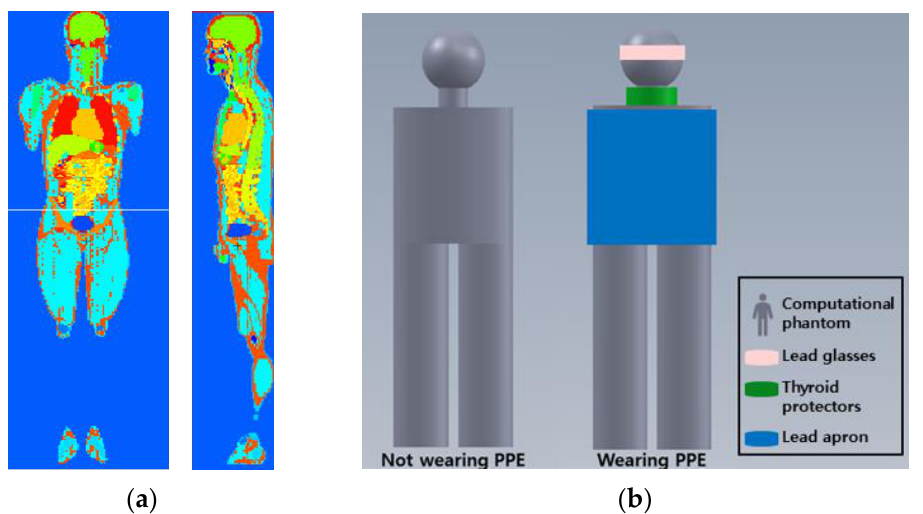
Figure 2. Computational phantom for Monte Carlo simulation. ( a ) Screenshot of Korean typical man-2 (KTMAN, sagittal and coronal plane); ( b ) the arrangement of the personal protective equipment (PPE) in the phantom. Lead glasses, thyroid protectors, and lead apron are located at eye, thyroid, and upper body.